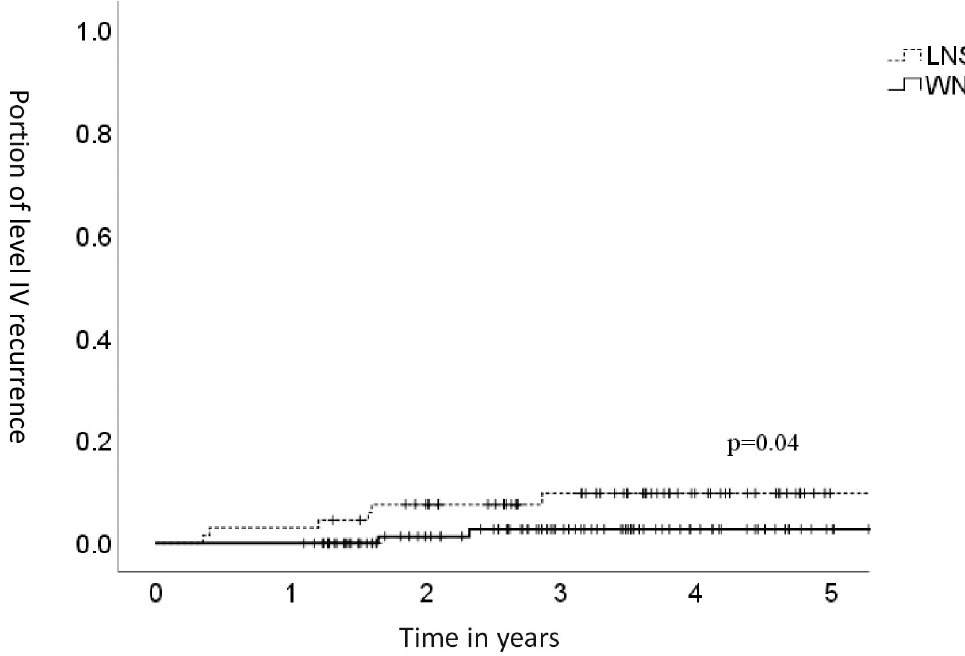
Fig 1. Incidence of level IV recurrence. WNI, whole-neck irradiation; LNS, lower-neck